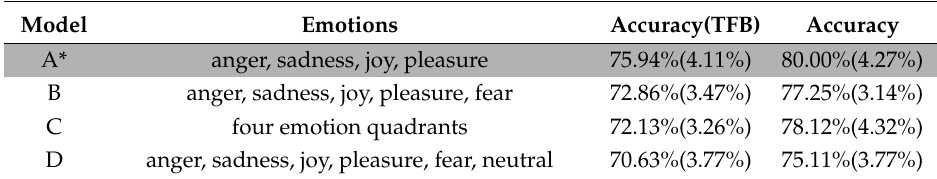
Table 7. Benchmark